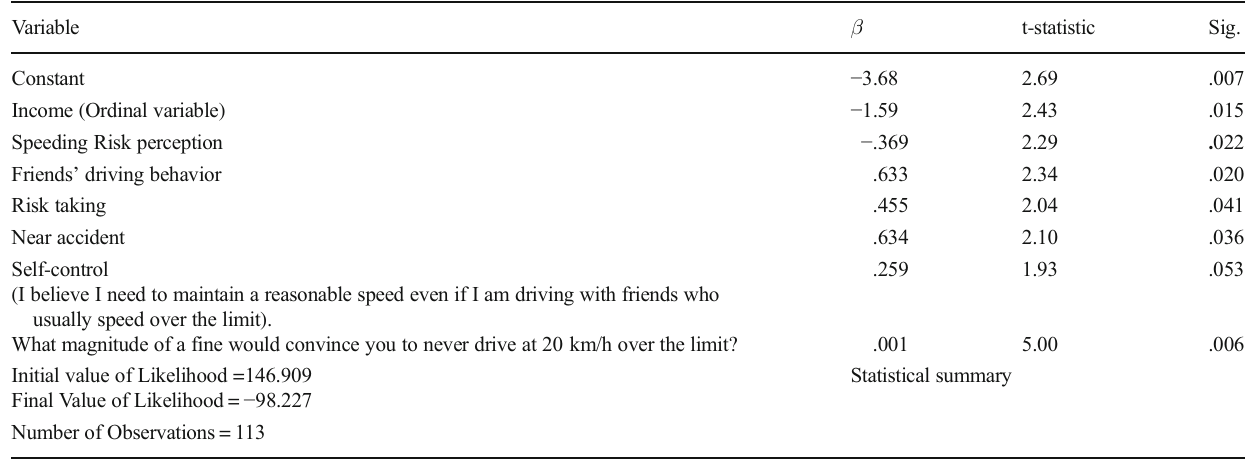
Estimation results of the speeding violations